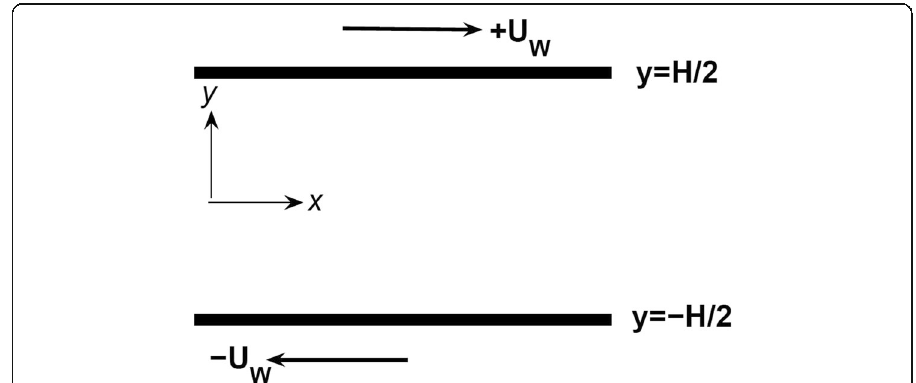
Fig. 1 Computational schematic diagram of the Couette